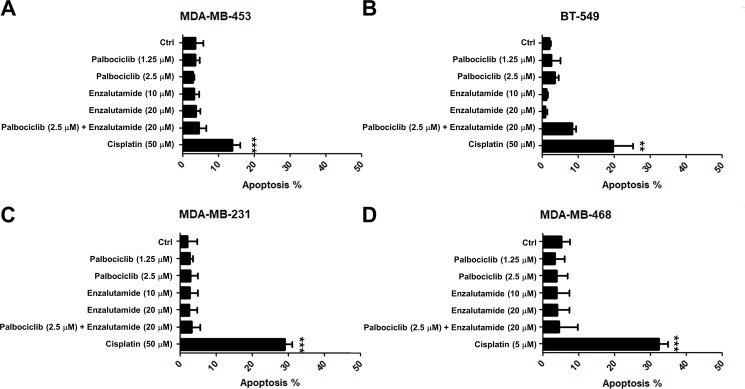
Palbociclib and enzalutamide do not result in apoptosis in TNBC cells.(A) MDA-MB-453, (B) BT-549, (C) MDA-MB-231 and (D) MDA-MB-468 cells were treated with DMSO (Ctrl), 1.25 and 2.5 μM palbociclib, 10 and 20 μM enzalutamide, combination of 2.5 μM palbociclib and 10 μM enzalutamide, cisplatin, and doxorubicin for 48 h, the percentage of apoptotic cells were analyzed by flow cytometry. The means ± SEM of three independent experiments performed in triplicate are shown. **P < 0.01; ***P < 0.001.